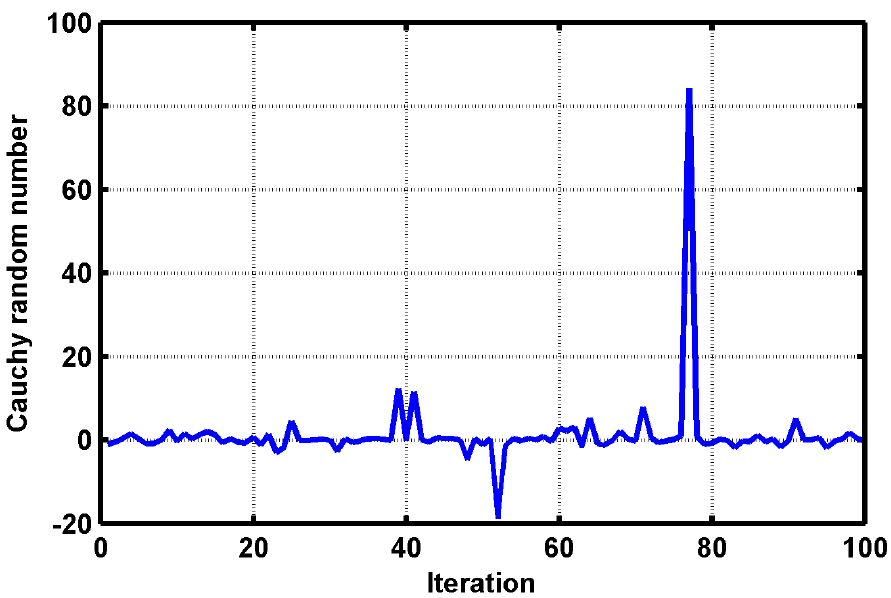
Figure 3. Whale position update inspired from Cauchy